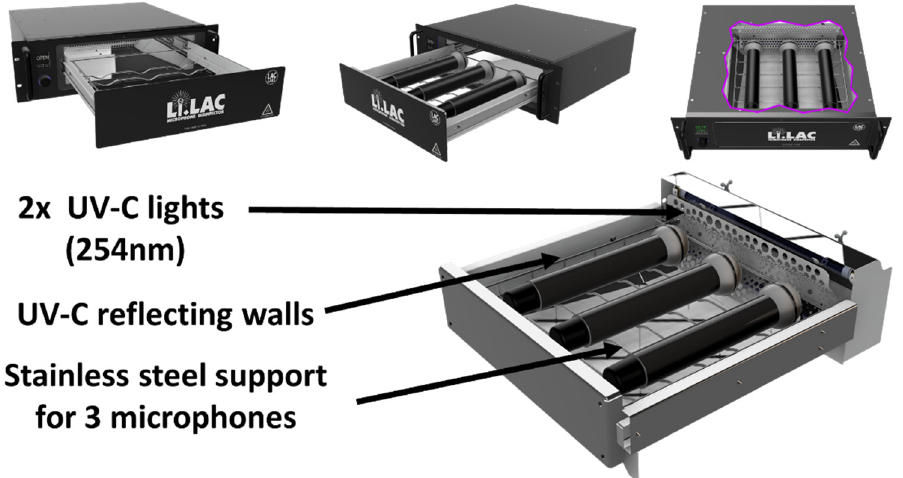
Figure 2. Basic design of the UV-C disinfection device that can contain up to three microphones at the same time. The microphone support slides into a shielded casing that contains two UV-C lamps. The efficiency of irradiation is enhanced by the usage of UV-C reflecting walls.